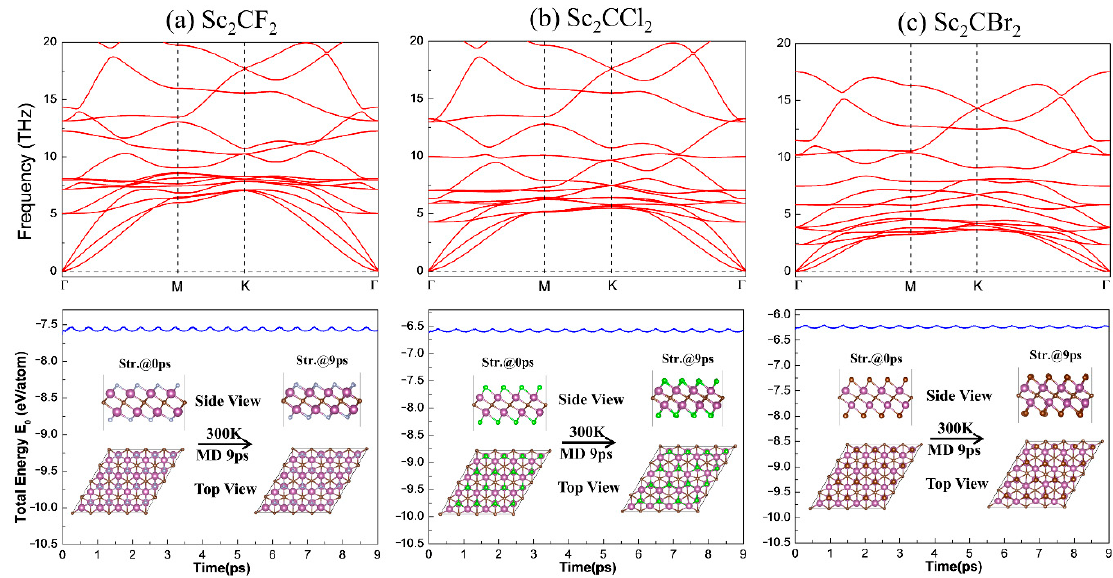
Figure 3. Phonon dispersion curves (upper panel), total energy changes and structure snapshots (lower panel) from 0 to 9 ps from AIMD calculations for ( a ) Sc 2 CF 2 , ( b ) Sc 2 CCl 2 , and ( c ) Sc 2 CBr 2 .